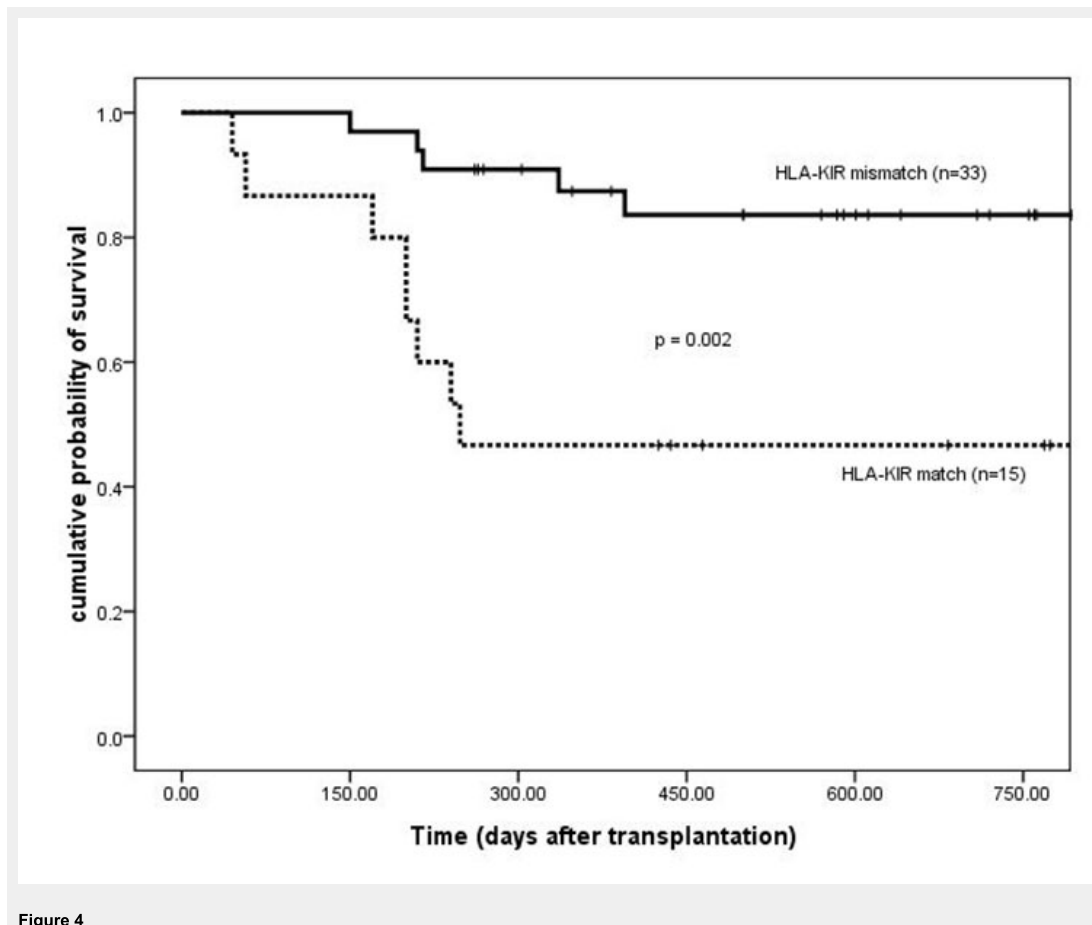
Figure 4 Disease-free survival of patients based on HLA-KIR match/mismatch group. HLA = human leukocyte antigen; KIR = killer immunoglobulin-like